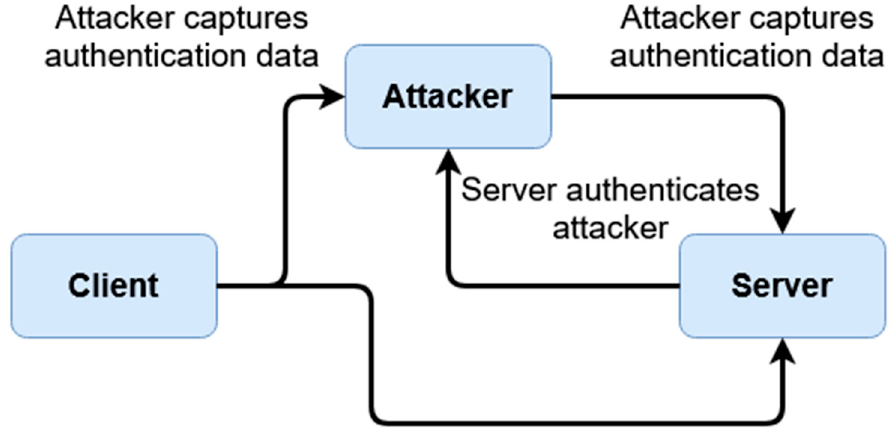
Figure 12. A replay attack under normal authentication pretenses.